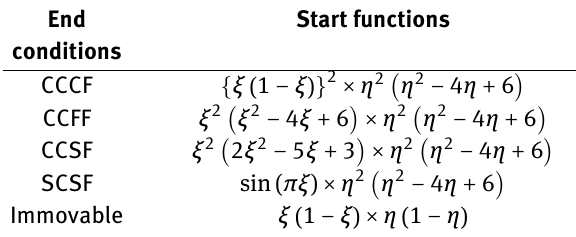
Table 1: Start functions for different boundary